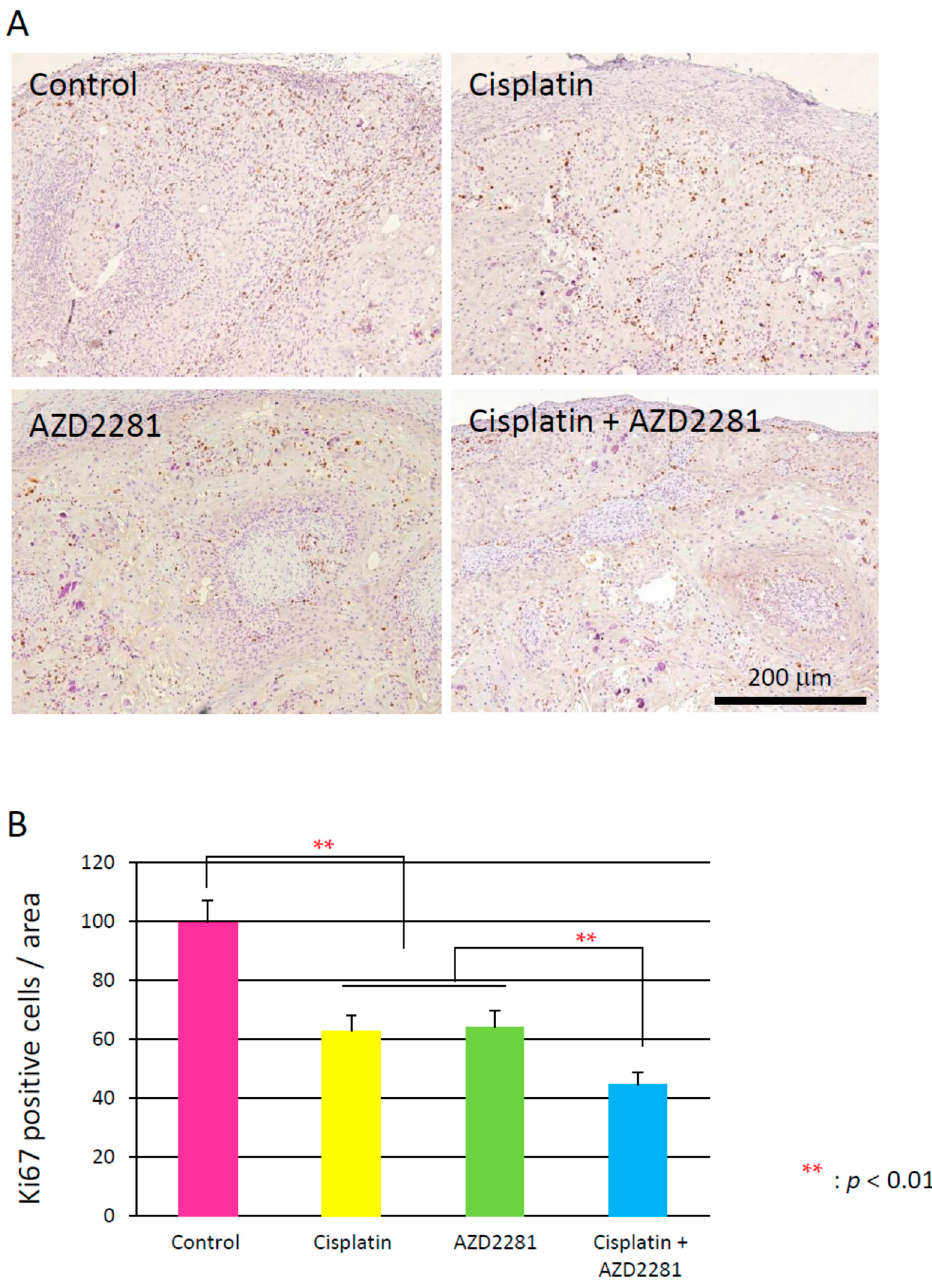
Figure 6. ( A ) Immunohistochemical analysis of Ki67 in xenografted tumors of control ( upper left ); cisplatin ( upper right ); AZD2281 ( lower left ); and combination ( lower right ) groups. Scale bar, 200 µm; ( B ) Ki67-positive cells per area in each treatment group. ** p < 0.01.